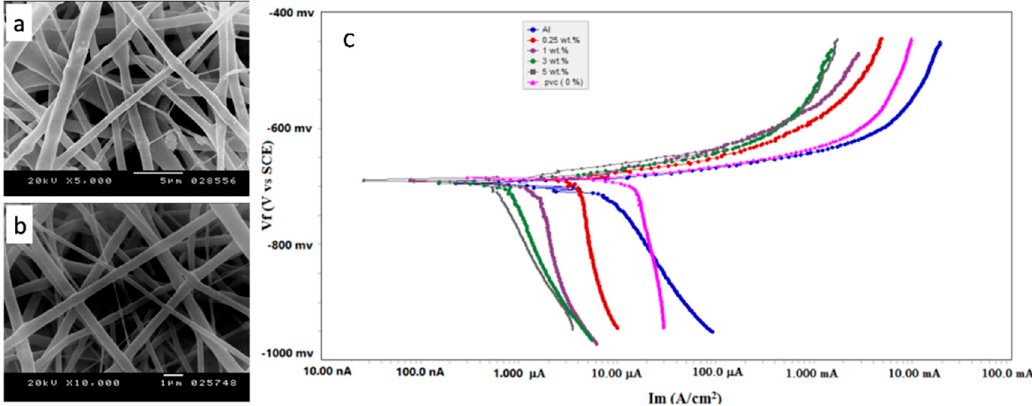
Figure 16. SEM images of ( a ) neat PVC-NFs ( b ) creia embedded PVC-NFs and ( c ) Tafel curves for electrochemical experiments of aluminium coated with PVC-NFs with and without addition of ceria in 0.1 M HCl.